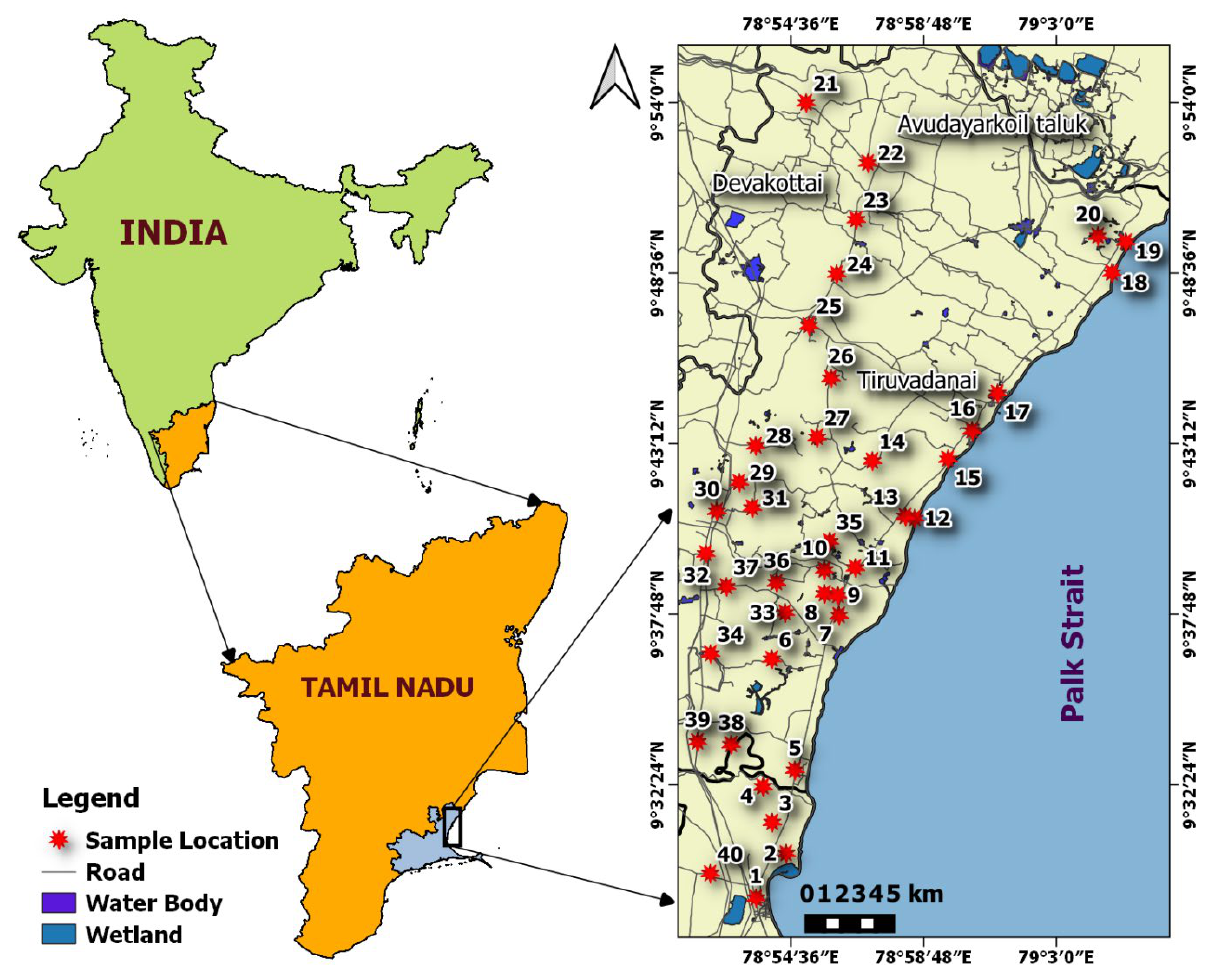
Figure 1. The sample locations in the study area map.